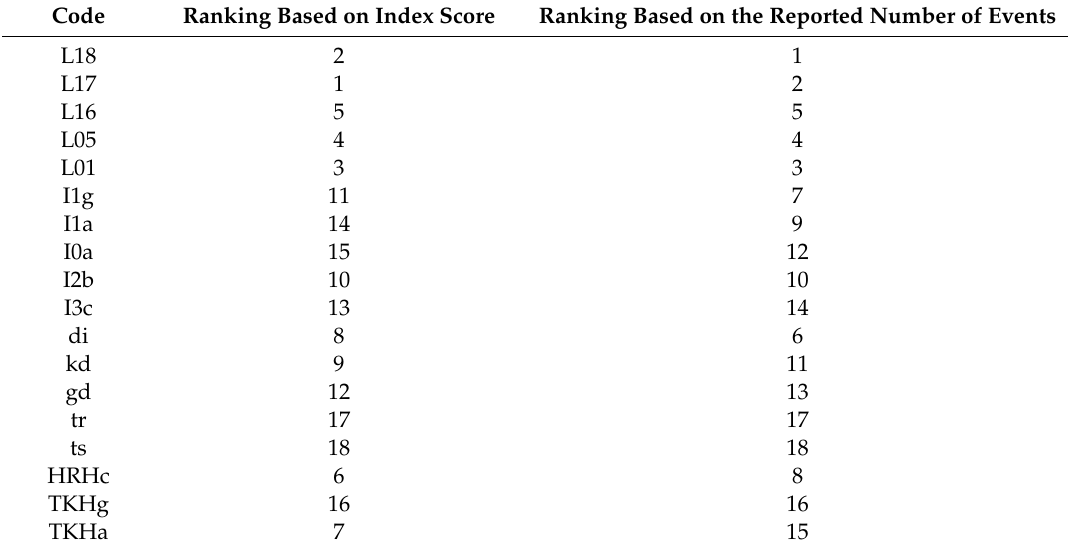
Table 10. Comparison of